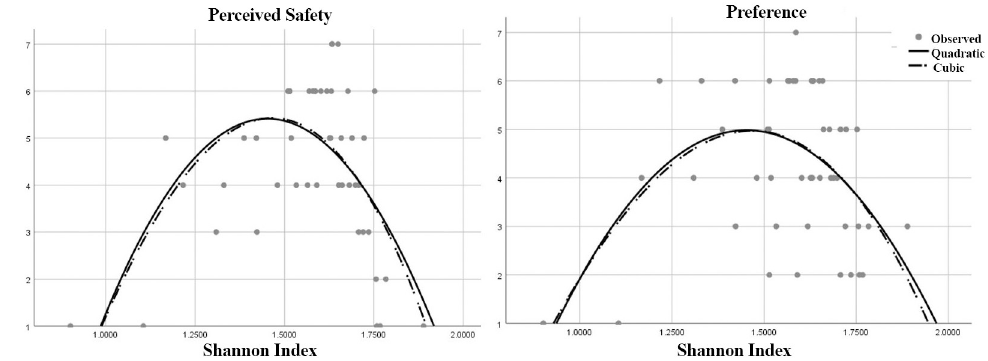
Fig 5. Non-linear relationship between the perceived safety, preference with Shannon Diversity Index